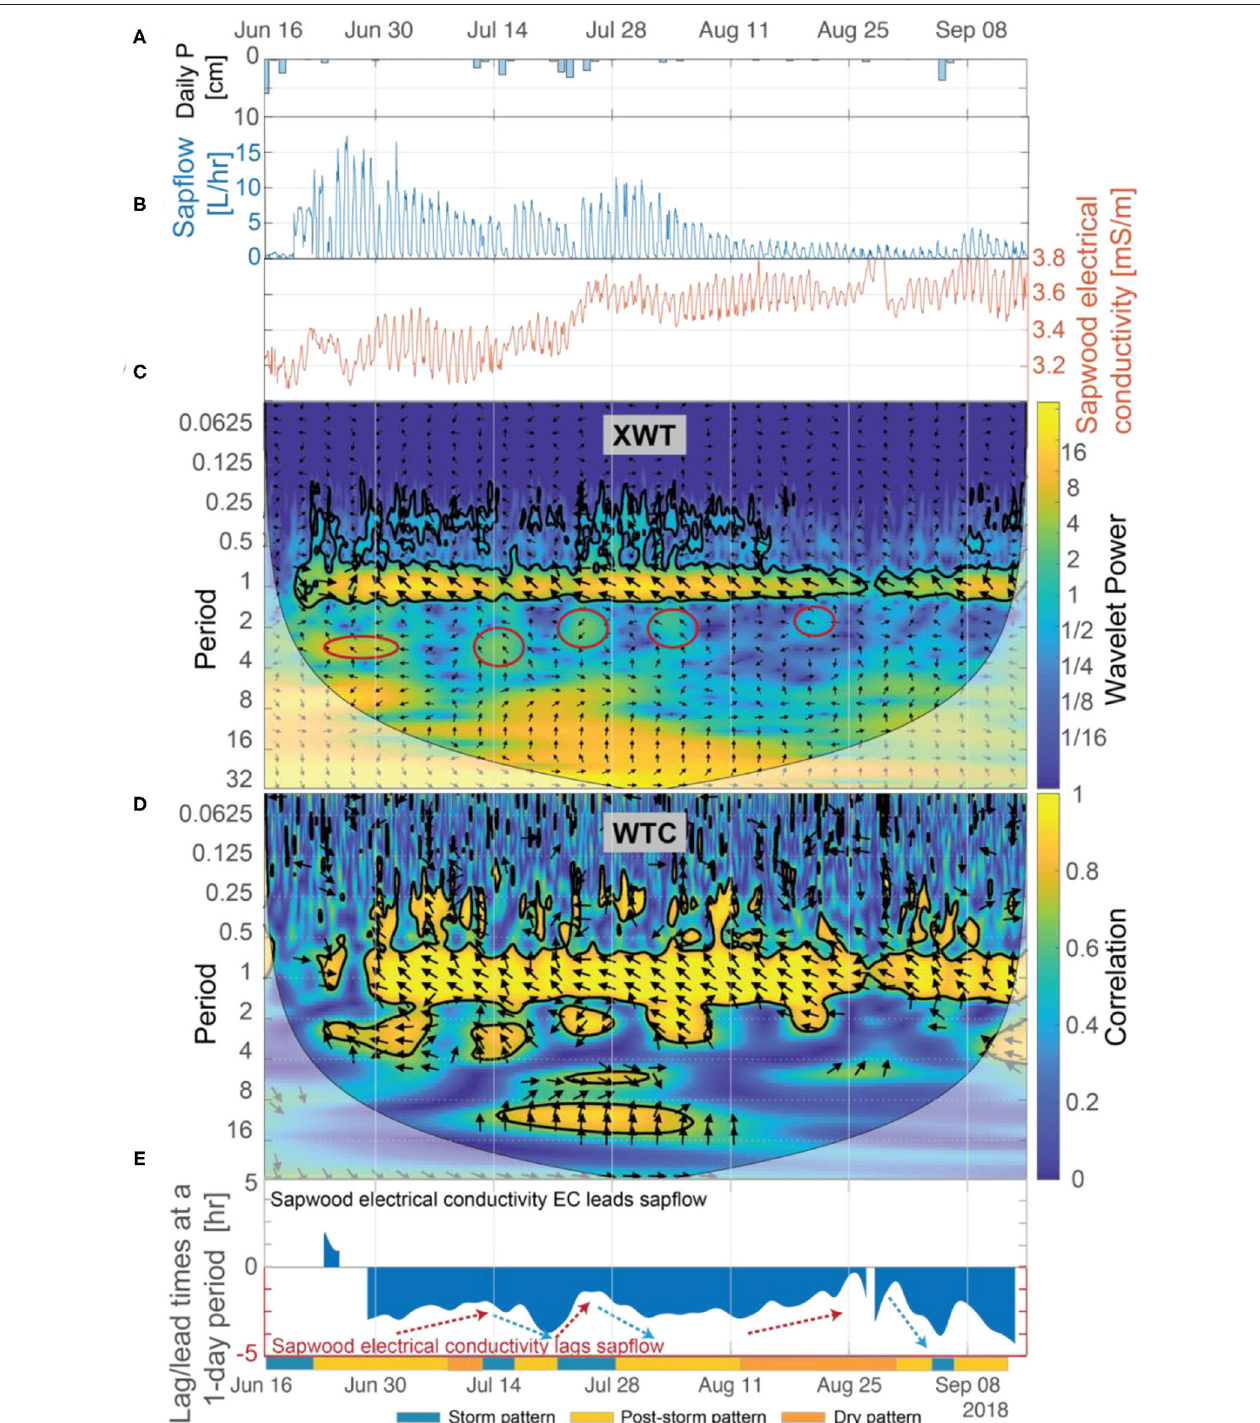
FIGURE 6 | (A) Daily precipitation, (B) sapflow and inverted sapwood electrical conductivity, (C) the XWT of sapflow and inverted sapwood electrical conductivity, (D) the WTC of sapflow and inverted sapwood electrical conductivity, and (E) the lead/lag calculated using Equation (7) and the phase angle of arrows at a 1-day period between sapflow and inverted sapwood electrical conductivity. Regions in time-frequency space in the XWT that had moderately high wavelet power, periods > 1-day, and where the WTC identified high correlation are outlined with red circles. The regions outlined in red coincide with the storm events. Red arrows highlight periods when we hypothesize that progressively drier conditions increased stomatal regulation, and subsequently decreased lag times. Blue arrows highlight periods when we hypothesize that increased moisture, due to precipitation, decreased stomatal regulation, subsequently increasing lag times.